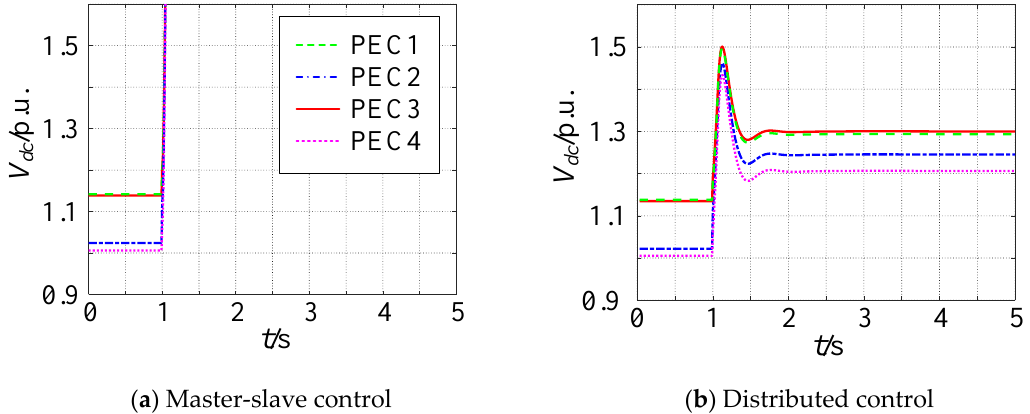
Figure 16. DC bus voltage performances under converter outage with different control schemes.